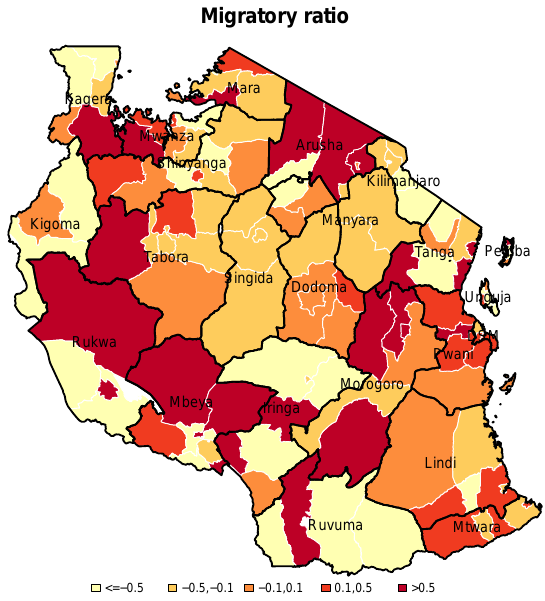
Figure 1 – Ratio between immigrants and emigrants across